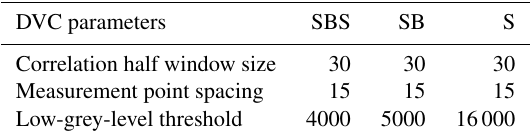
Table 1. Correlation parameters used to conduct digital volume correlation for different data series. The correlation window size, usually used in digital image correlation (DIC) applications, cor- responds to 1 + 2 × the half window size given in the table. The threshold value is simply implemented to skip correlation windows placed outside the sample based on their mean grey